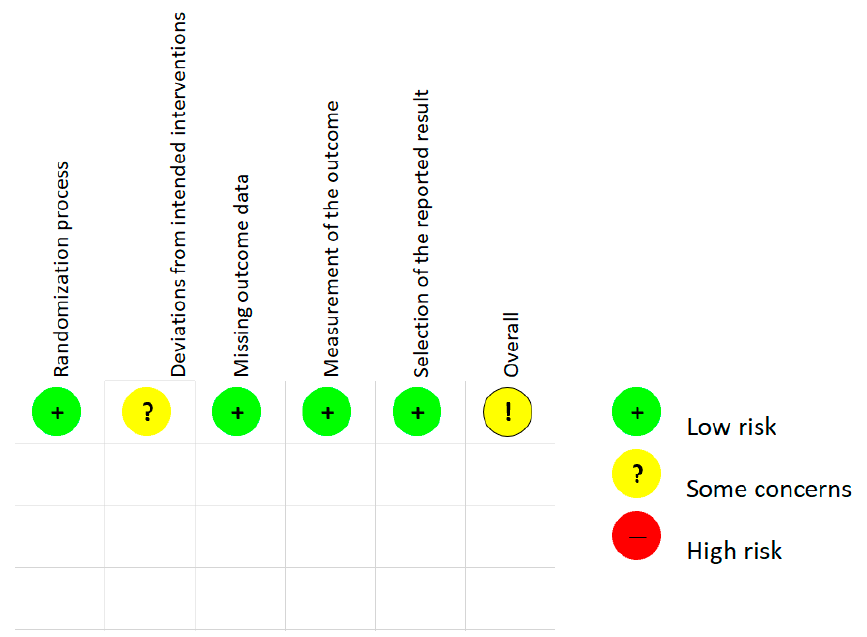
Figure 2. RoB-2 assessment. (Lethinen et al. 2019).